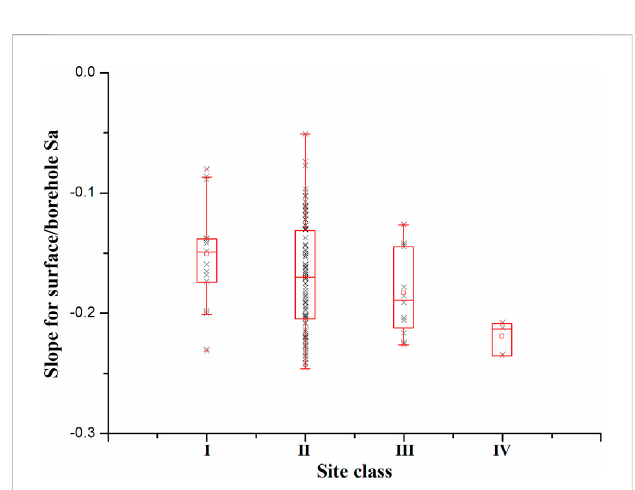
FIGURE 9 The scatter diagrams and box-plots for the slopes of the linear fi ttings for platform values of surface/borehole Sa for all the 137 stations on each site